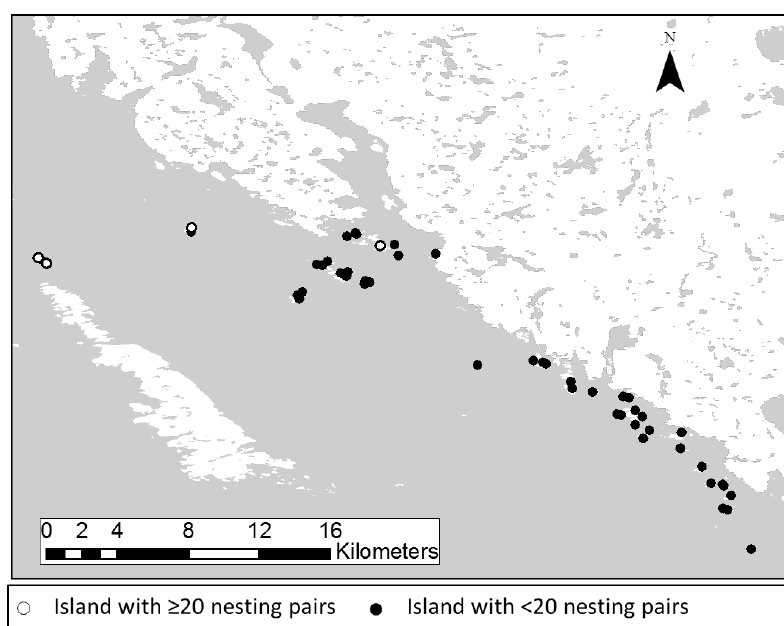
Figure A2.12. Survey zone 12: Central Frobisher Bay, Frobisher